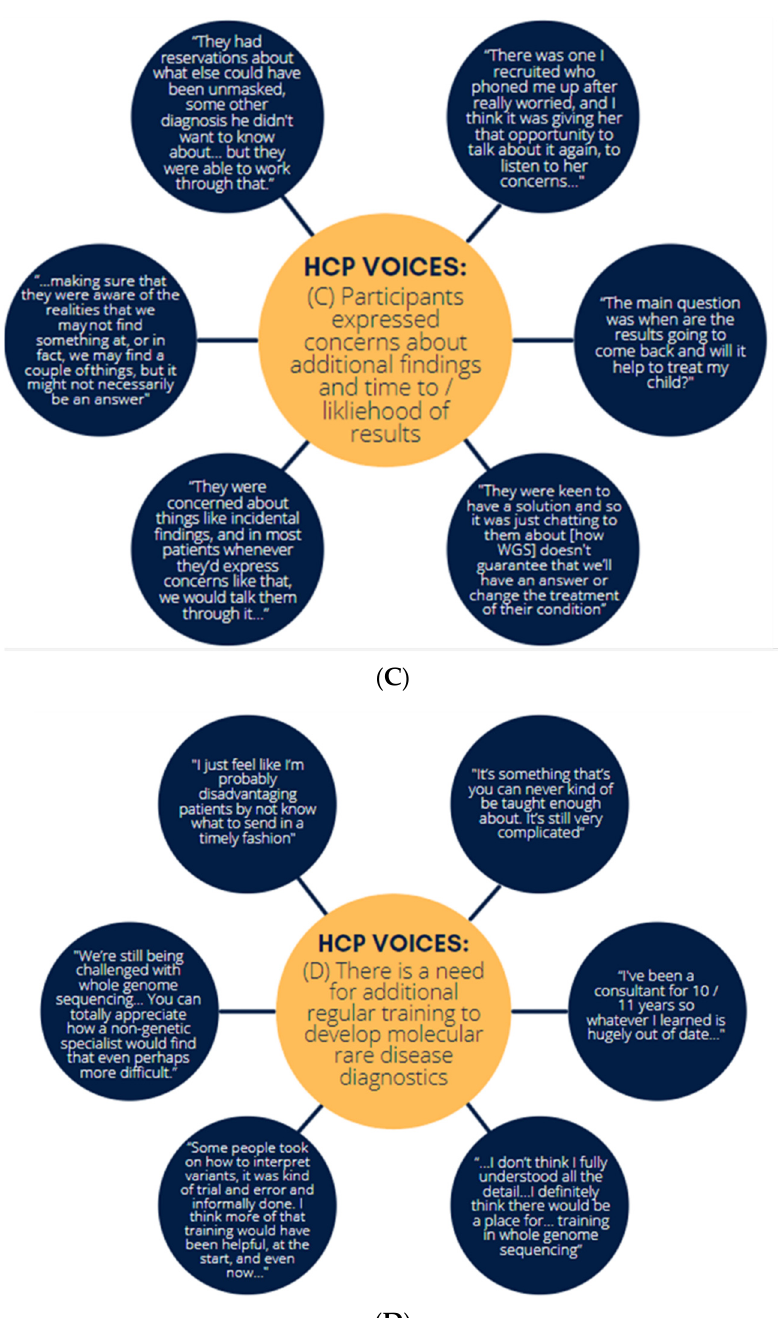
Figure 5. HCP voices about ( A ) the importance of WGS for rare disease diagnostics, ( B ) workload burden of WGS and difficulties in the consenting process, ( C ) participant concerns regarding WGS and ( D ) the need for additional training on molecular diagnostics for rare